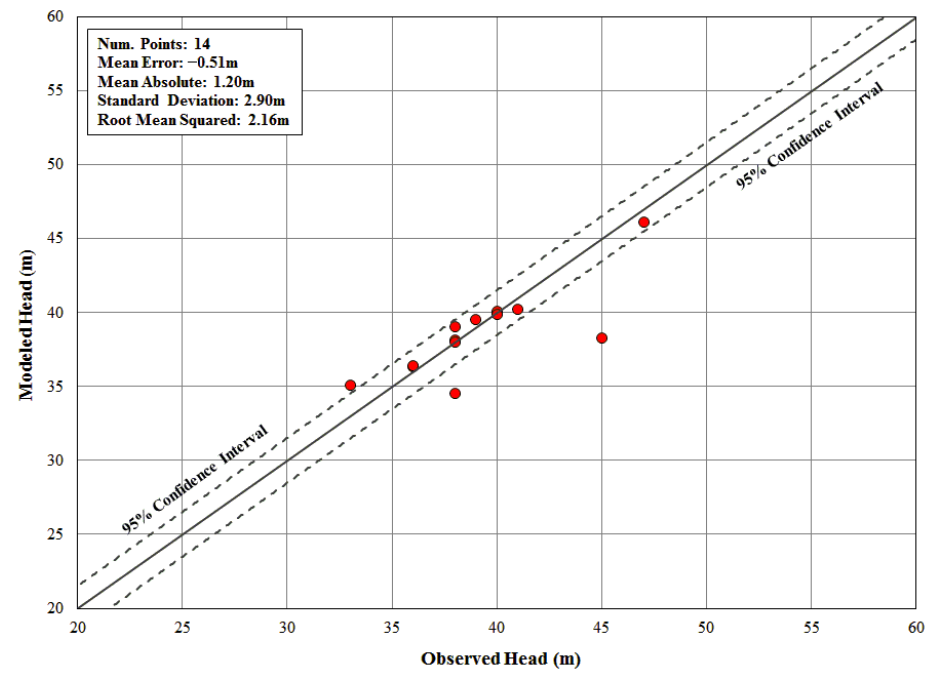
Figure 9. Model verification. Calculated vs. observed groundwater head in observation wells.